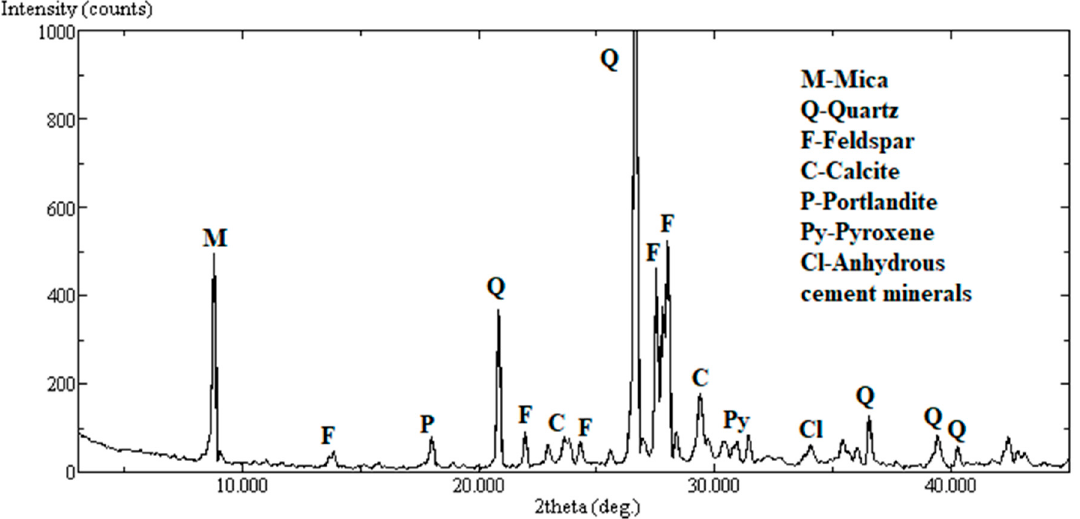
Figure 9. X-ray diffraction.